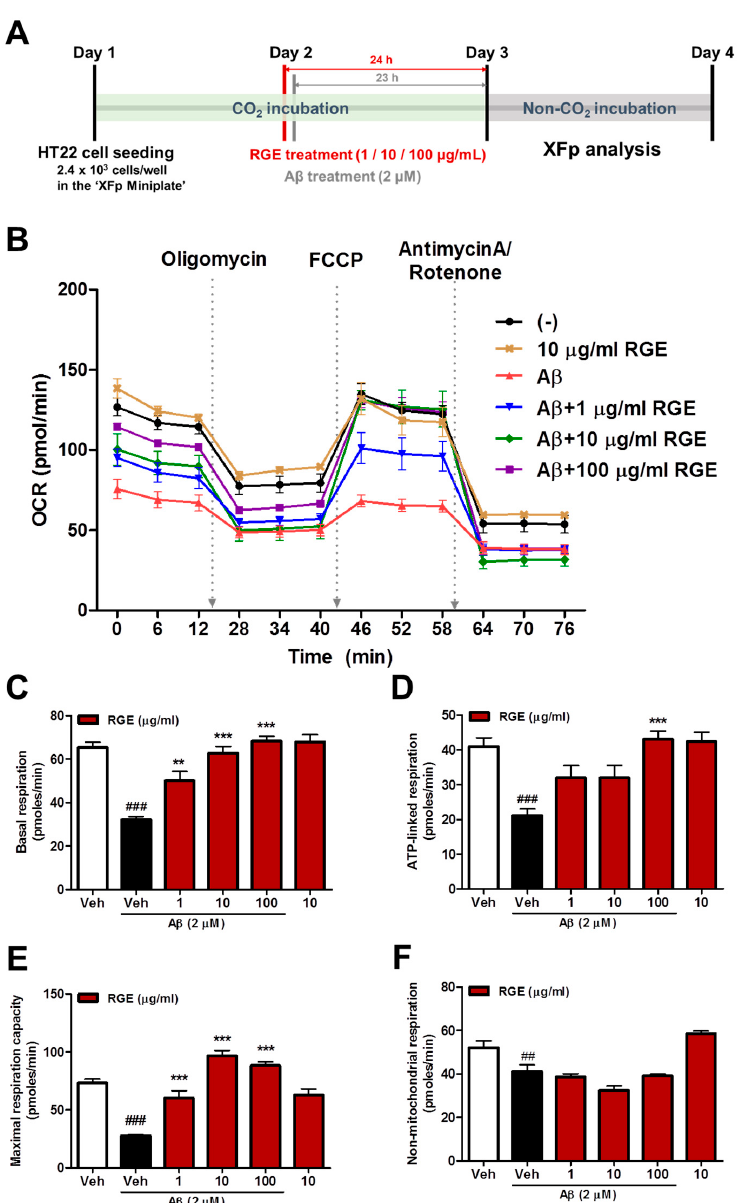
Figure 1. Red ginseng extract (RGE) prevents amyloid beta (A β )-mediated mitochondrial dysfunction in HT22 cells. ( A ) Outline of the experimental design and timeline for mitochondrial respiration assessment with Seahorse XFp analysis. ( B ) The Seahorse assay using the XFp analyzer was performed to measure the oxygen consumption rate (OCR) after treatment with A β (2 μ M) and A β + RGE (1, 10, and 100 μ g/mL). Basal respiration ( C ), ATP-linked reparation ( D ), maximal respiration capacity ( E ), and non-mitochondrial respiration ( F ) were measured by analyzing OCR values by adding oligomycin (1 μ M), FCCP (1 μ M), rotenone (0.5 μ M), and antimycin A (0.5 μ M). Data are presented as mean ± SEM. ## p < 0.01 and ### p < 0.001: vehicle-treated cells (white bar) versus A β -treated cells (black bar). ** p < 0.01 and *** p < 0.001: A β -treated cells versus A β + RGE-treated cells (red